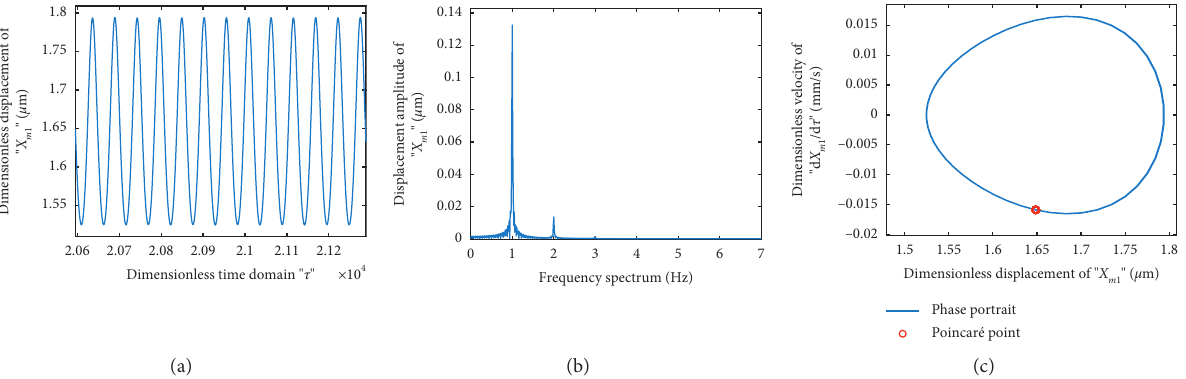
Figure 4: The dynamic response of system X